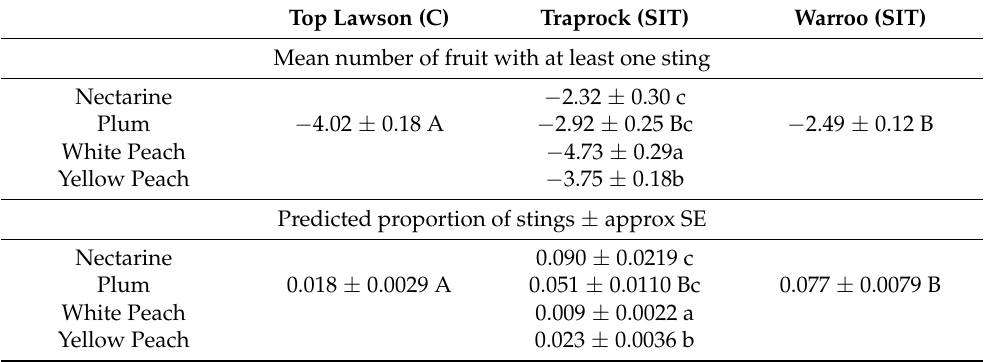
Table 2. Fruit type and orchard effects on proportion of B. tryoni stings (Mean ± SE from the sting analysis (logistic scale) and predicted proportion of B. tryoni stings ± approx SE (back transformed).